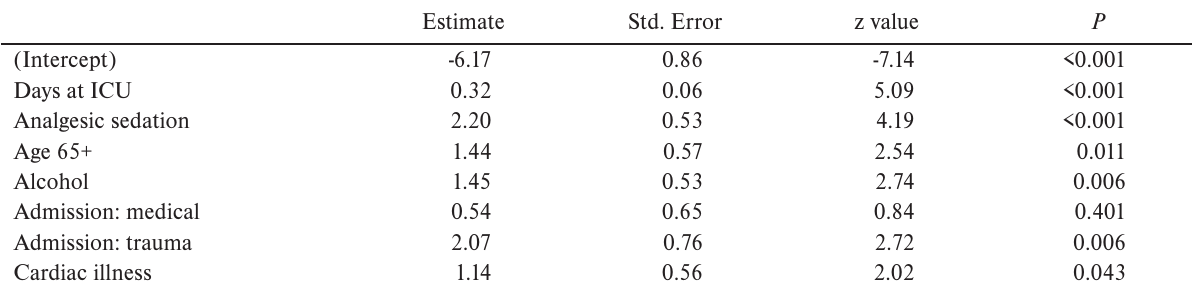
Table 3. Logistic regression model of CAM+ vs CAM-.